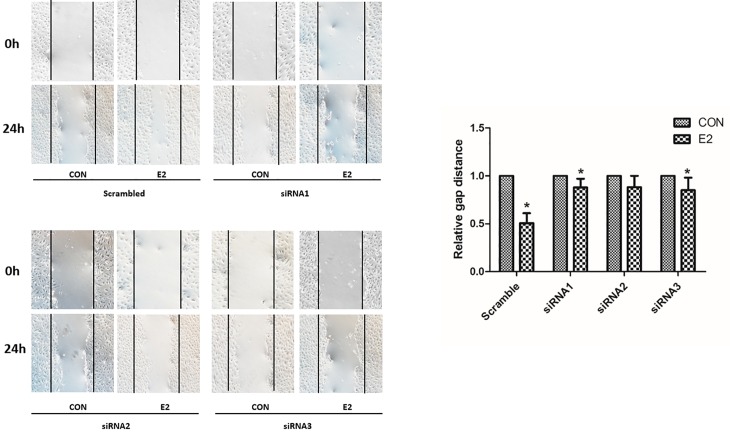
Wound scratch assay showed E2 promotes HUVEC migration via striatin.HUVECs were transfected with striatin siRNA1, 2, 3 or scrambled siRNA for 24h. Then cells were scrapped to create a cell-free (wounded) area. Cells were incubated with 10nM E2 or with solvent as control for another 24h. Migration was monitored. Representative images of cell migration are shown. Gap distance in CON group was normalized to 1, *p<0.01 versus CON. Bars represent SD, n = 6.